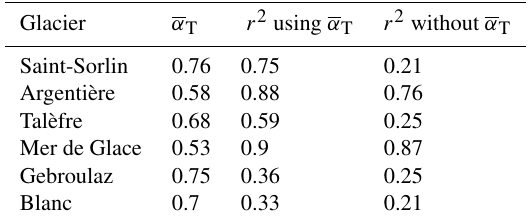
Table 3. Coefficients of determination for the relationship between the winter SMB b w and the integrated winter albedo, computed with and without the albedo threshold α T